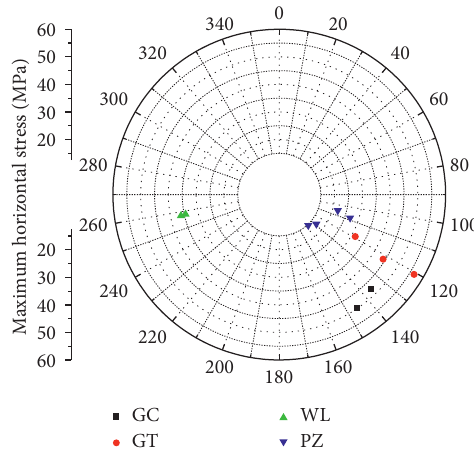
Figure 5: Maximum horizontal stress